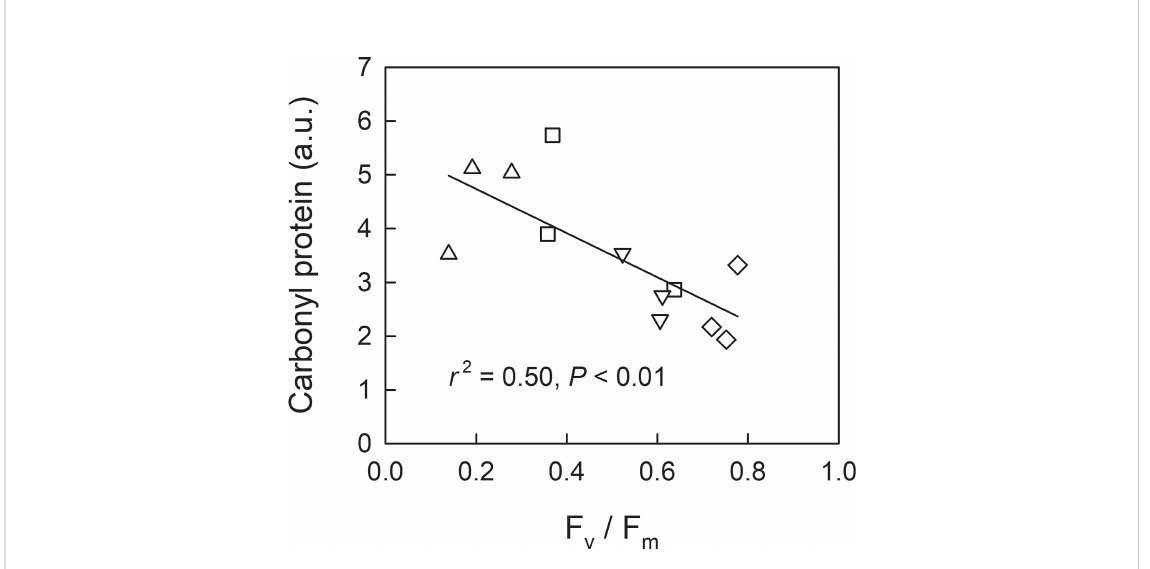
FIGURE 6 Relationship between F v /F m and carbonyl protein in leaves (measured and sampled on 19 th Oct) of fullmoon maple seedlings grown under shade (L0, diamond), transferred from shade to open conditions on 5 th Oct (LH1, square), 12 th Oct (LH2, triangle-up), and 18 th Oct (LH3, triangle-down). The amount of carbonyl protein was expressed in an arbitrary unit (a.u.). Linear regression analysis was conducted for the pooled data across the light